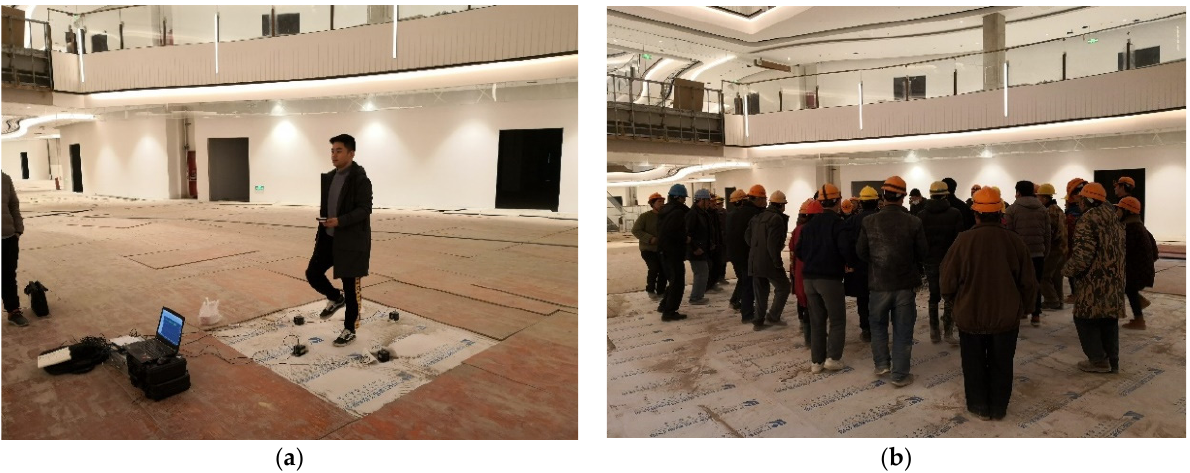
Figure 6. Field tests of human-induced vibration: ( a ) single pedestrian walking in place; ( b ) 40 pe- destrians walking in place.